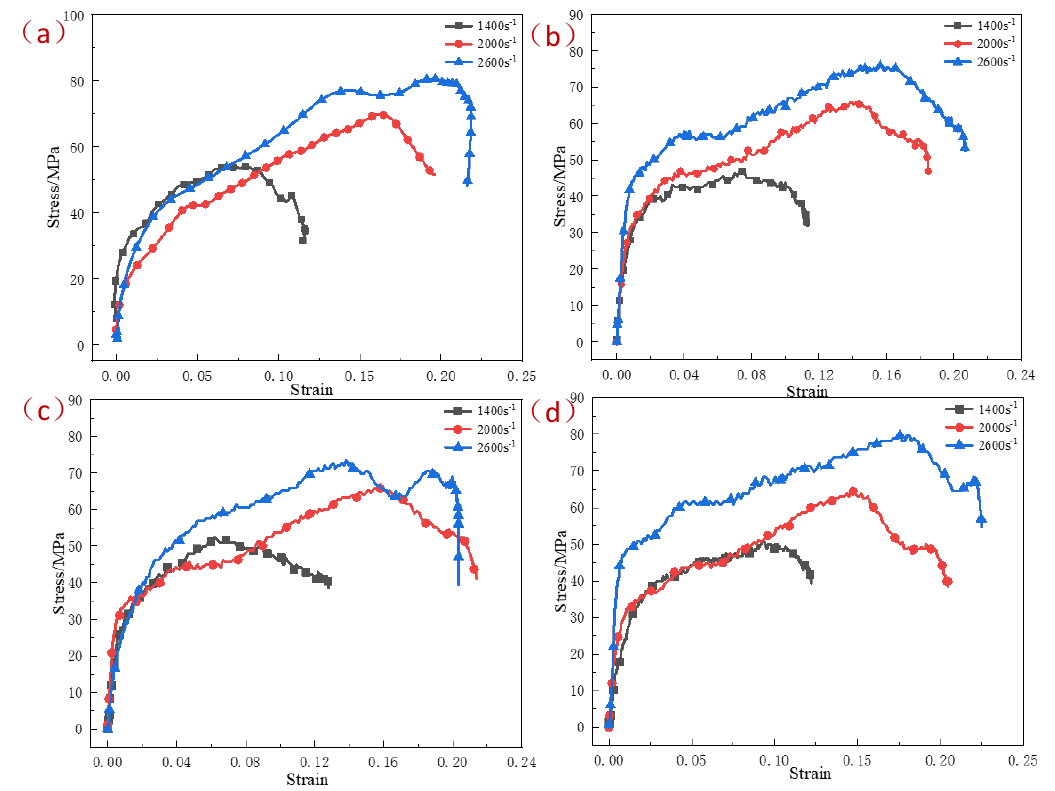
Figure 5. The stress–strain curves of specimens under the same pressing pressure and different strain rates at room temperature: ( a ) 200 MPa; ( b ) 400 MPa; ( c ) 600 MPa; ( d ) 800 MPa.